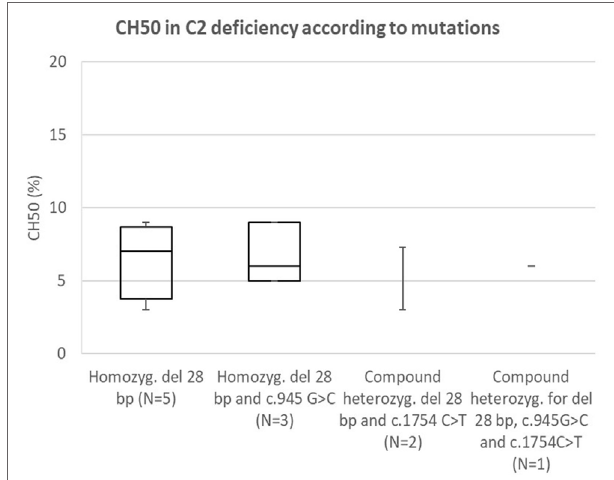
FigUre 6 | Comparison of CH50 between subjects with C2 deficiency, according to underlying genetic